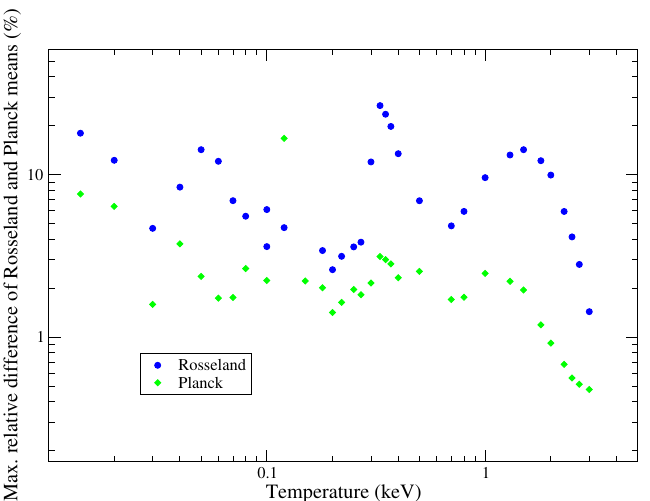
Figure 19. Maximum value of the relative difference (in absolute values) between the iron Rosseland (blue circles) and Planck (green diamonds) mean opacities of a calculation with a maximum number of 1000 superconfigurations and a maximum number of 10,000 superconfigurations as a function of temperature.